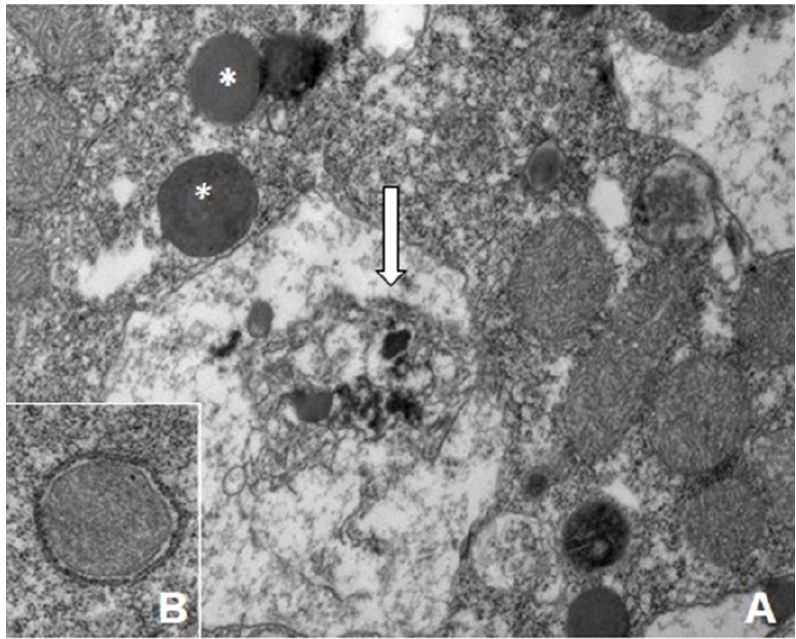
Figure 5. A. Detail of the cytoplasm from a vegetative cell of the ciliate Tetrahymena thermophila , exposed to As(V), 30 μ M, 24h, showing mitochondrial degeneration by mitophagy. Degraded mitochondria (*). Arrow points to an advanced au- tophagosome (x25k). B. Detail of an early mitoauto-phagosome (x25k).